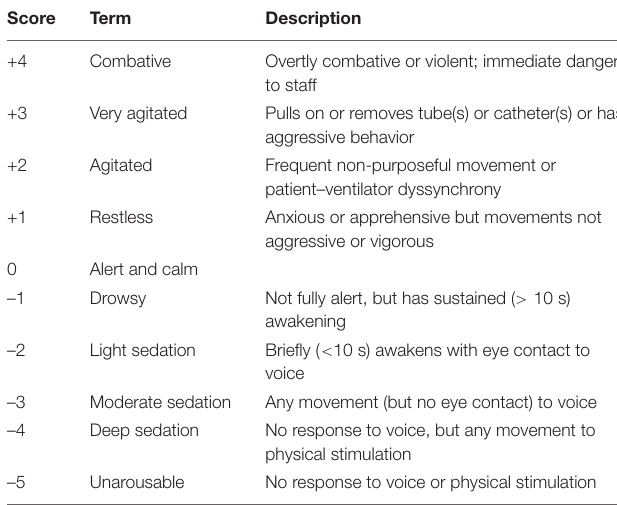
TABLE 1 | Richmond agitation and sedation scale